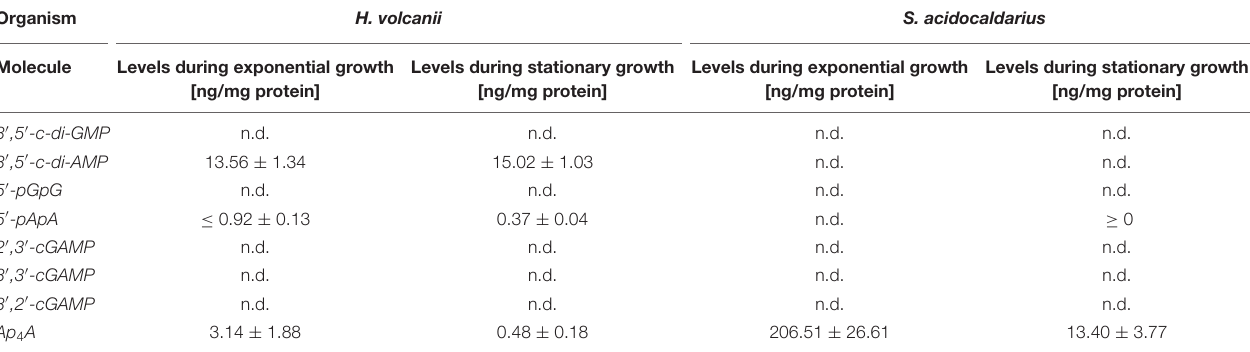
TABLE 3 | Summary of measured and detected di-nucleotide-based (putative) second messengers. Organism